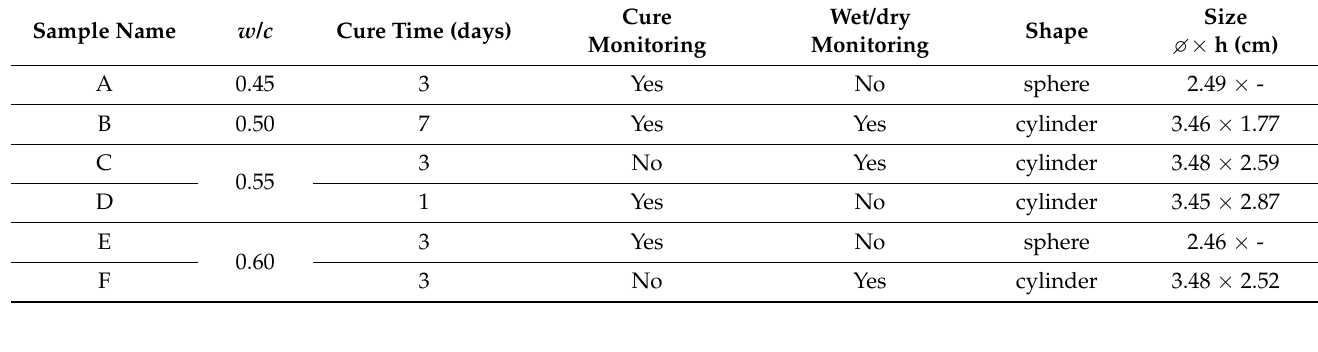
Table 1. Cement paste samples used for the cure and wet/dry cycle